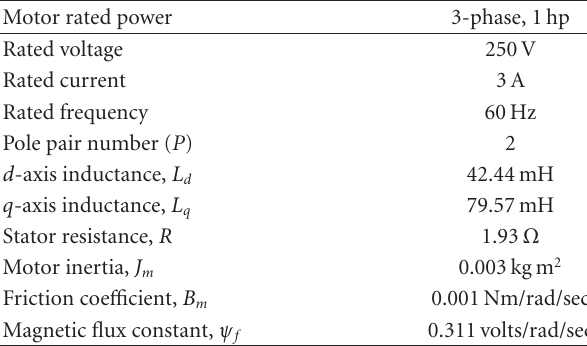
(iii) if Δ ω r is NL (negative low), T e is NL (negative low); (iv) if Δ ω r is NH (negative high), T e is NH (negative high).